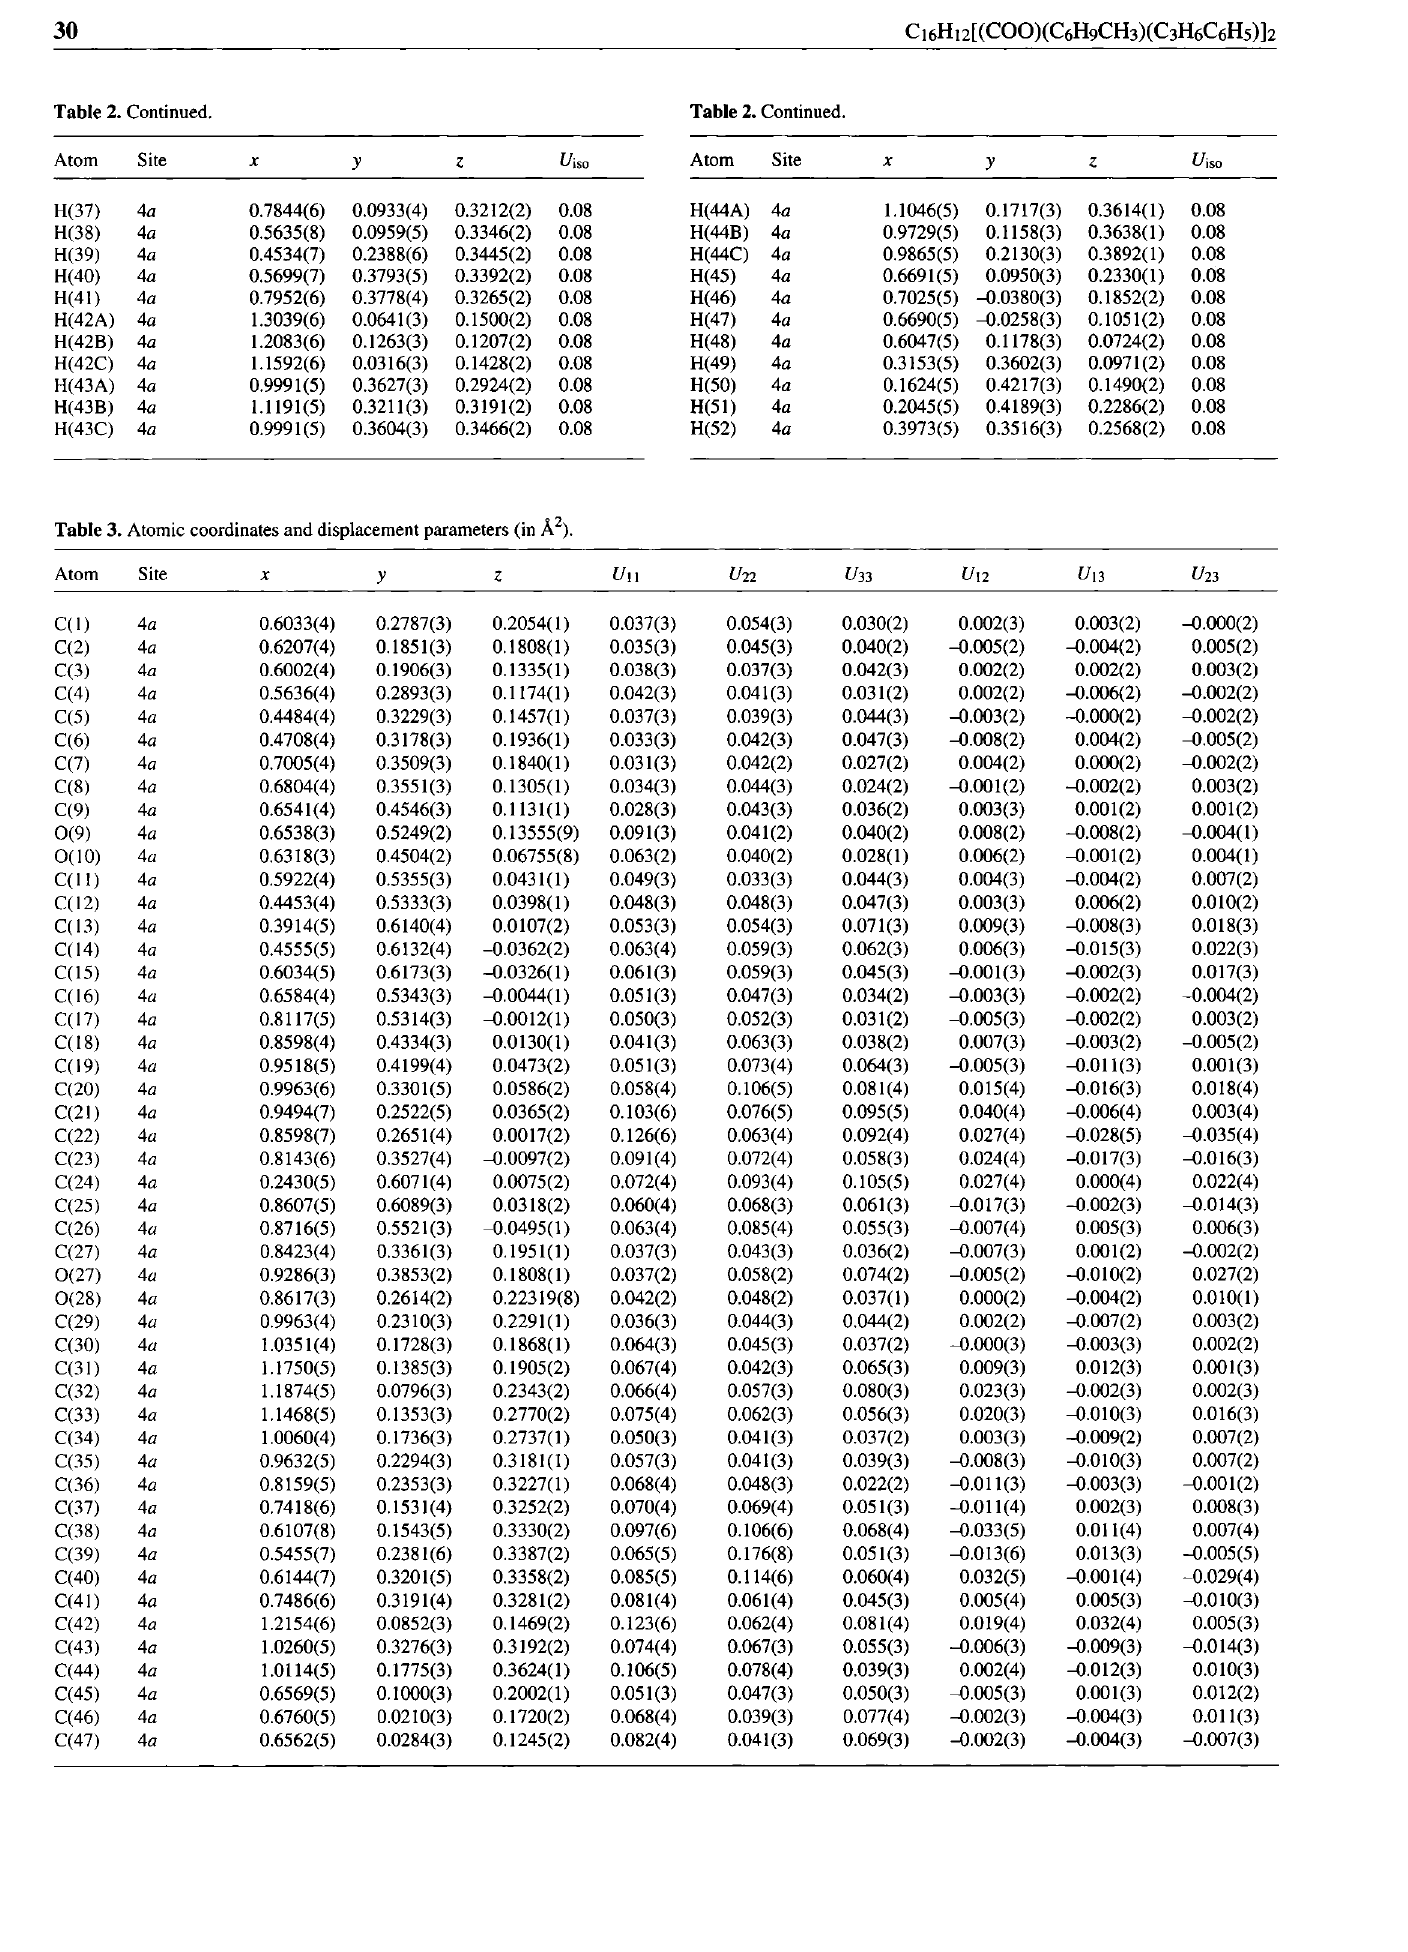
Table 3. Atomic coordinates and displacement parameters (in A 2